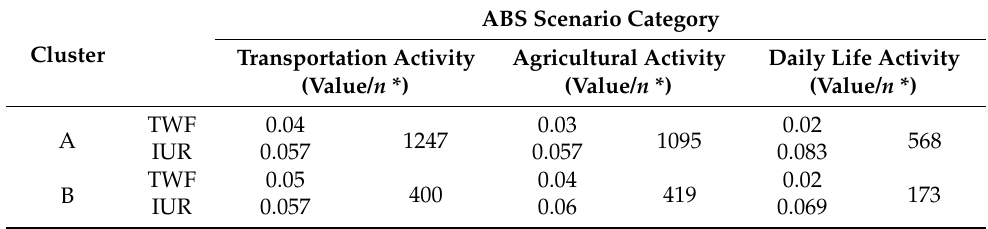
Table 4. TWF and IUR based on survey results of residents near the abandoned asbestos mines in South Korea. Cluster